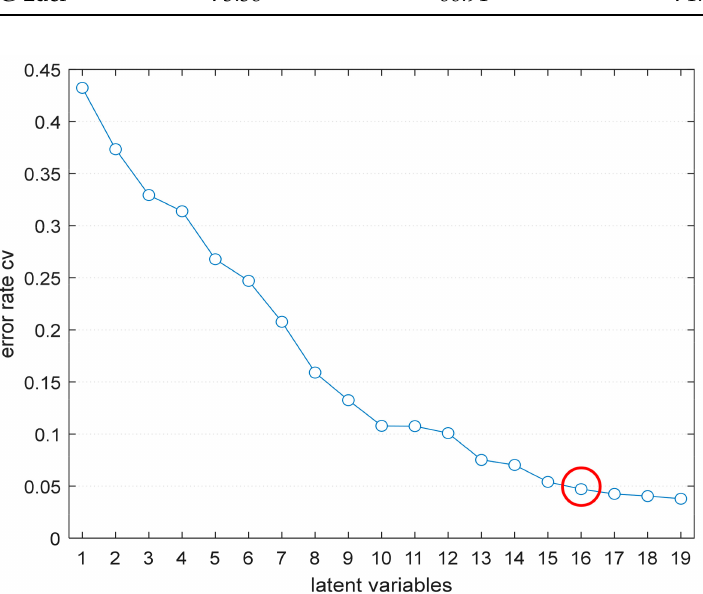
Figure 6. The optimal number of LVs determination in the PLS-DA model. LVs: latent